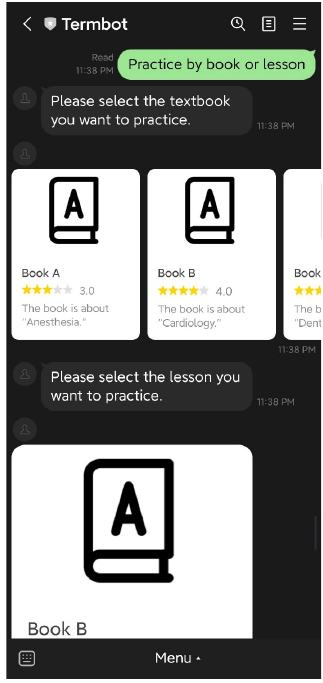
Figure 5. The function is “Practice by book or lesson”.